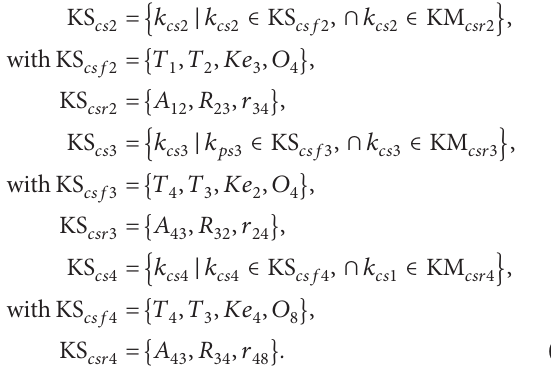
Figure 2: Framework of knowledge innovation mechanism based on linkages between periphery knowledge and core